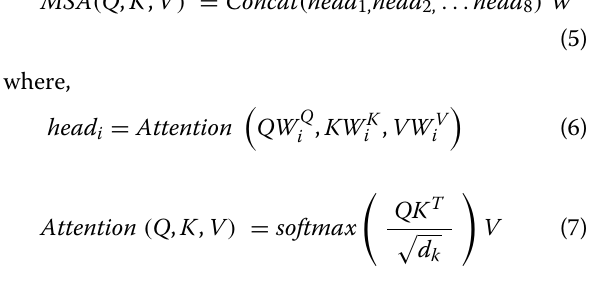
method are shown in Table 1. Position embeddings are added to the patch embeddings to retain positional infor- mation. The Transformer encoder is shown in Fig. 2(b) and consists of alternating layers of multi-headed self- attention (MSA) with eight attention heads and two multi layer perceptron (MLP) layers with 2048 and 1024 nodes with Gaussian error linear unit (GELU) nonlinearity in between. Layernorm (LN) is applied before every MSA and MLP layer, and residual connections are placed after each module. MSA is defined in [27] as